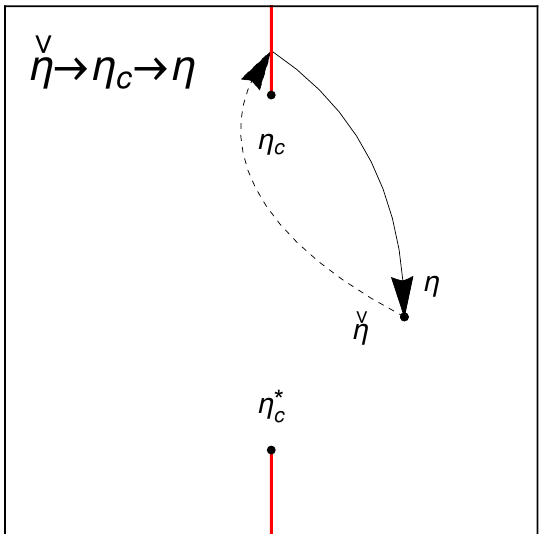
. η is on the “positive” c